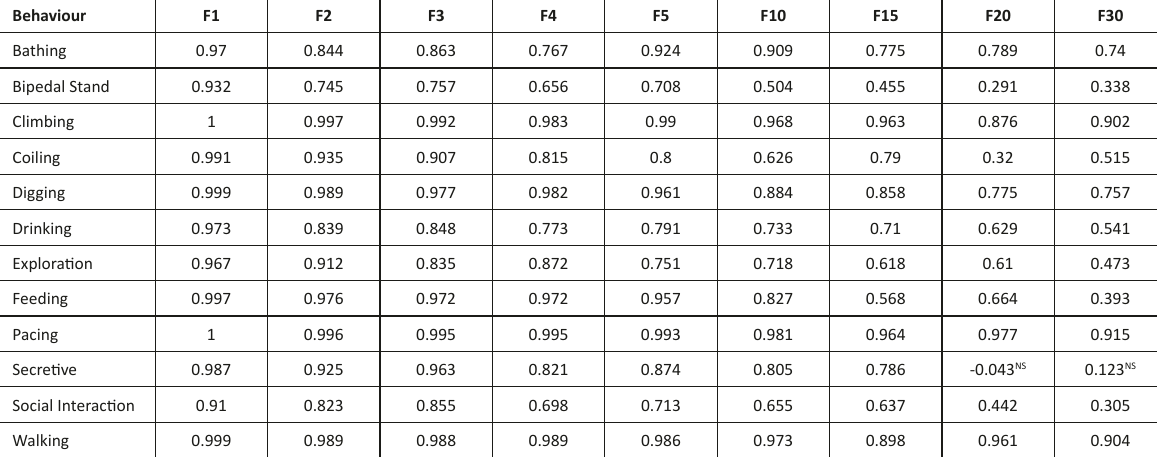
Table 5. Pearson’s Correlation Matrix for instantaneous behavioural sampling data with focal behavioural samplings, F1, F2, F3, etc at 1,2,3, etc. minutes intervals, showing that ‘correlation’ reduced with increasing time interval. NS = Not significant at 5% level.